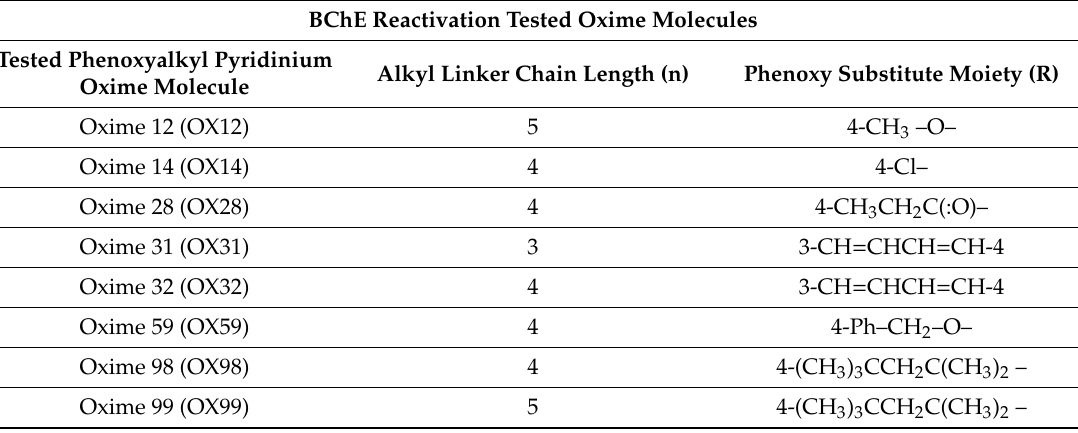
Table 2. List of oxime molecules used in the patent (Pub. No.: US 2017 / 0258774 A1) [84]. BChE Reactivation Tested Oxime